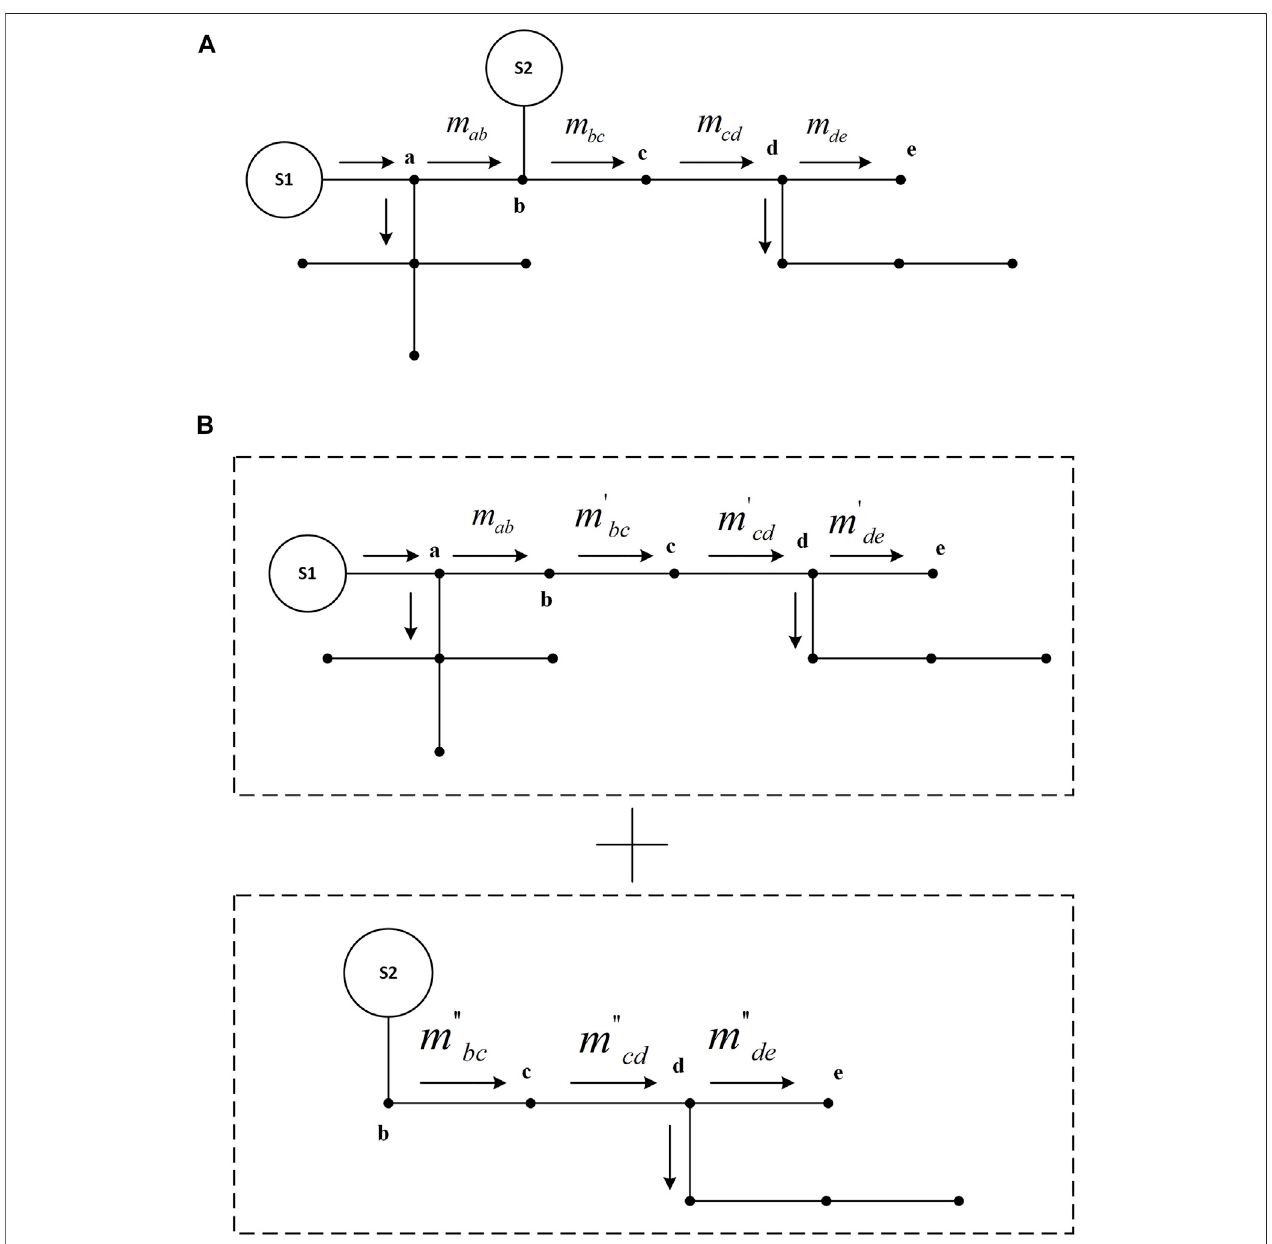
FIGURE 1 | (A) Multi-source radiant thermal system model. (B) Single-heat source radiant heat network model.